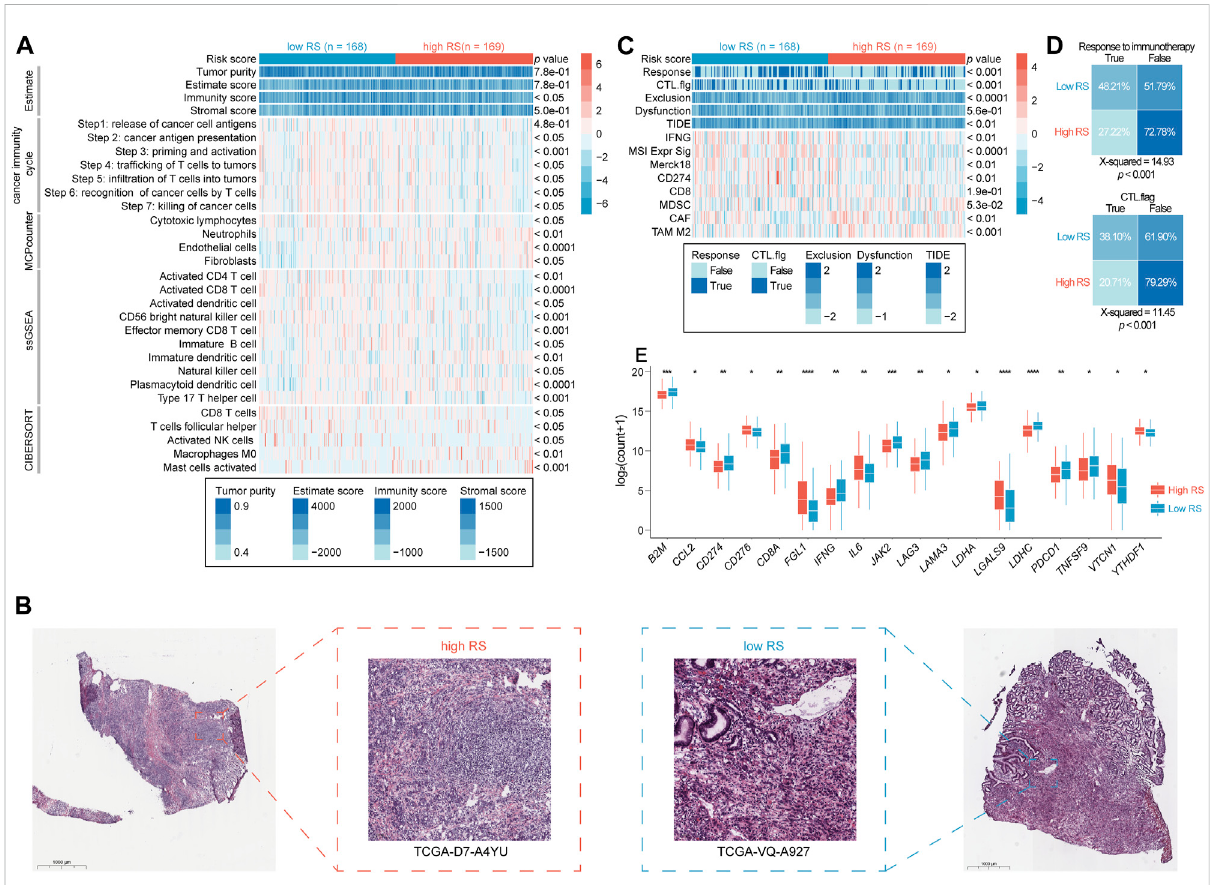
Supplementary Table S5). GSEA of oncogenic